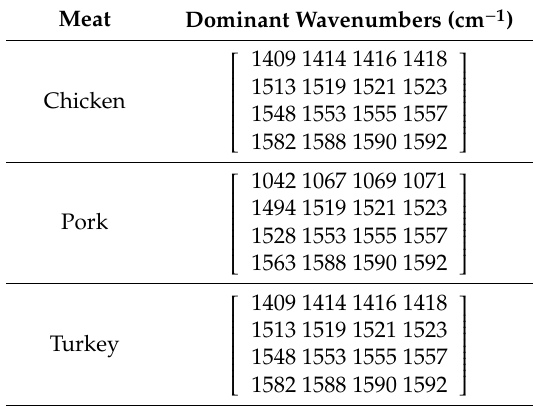
Table 5. Dominant wavenumbers for chicken, pork and turkey.